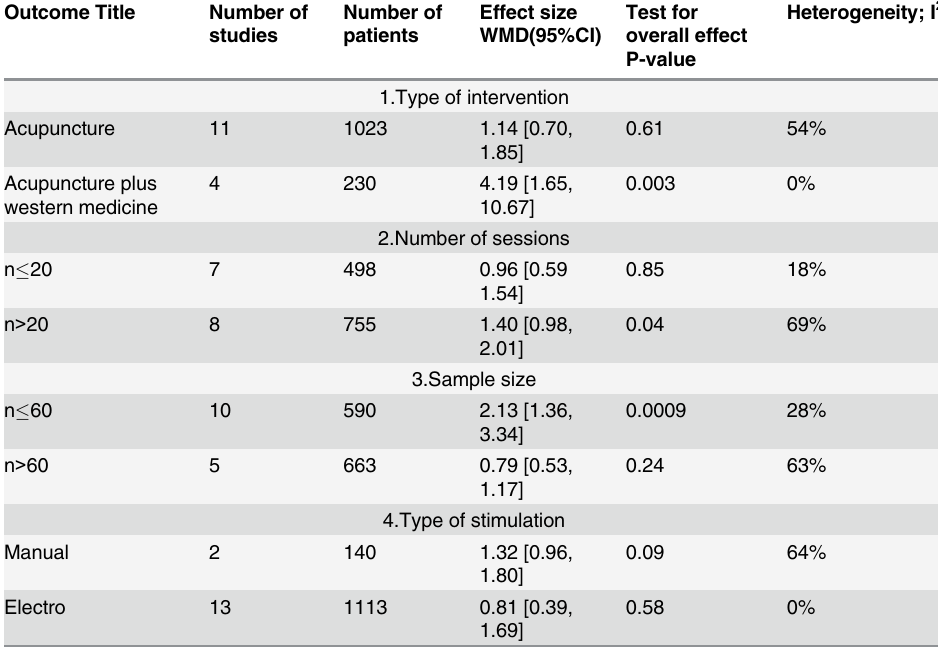
Table 4. Subgroup analysis and investigation of heterogeneity on efficacy